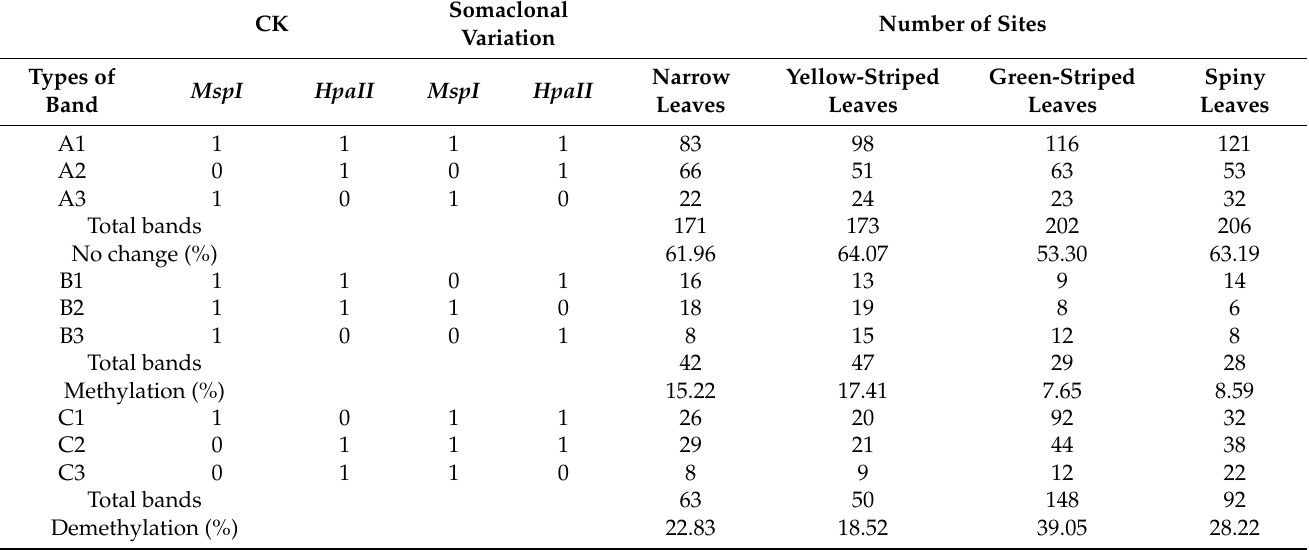
Table 1. The pairwise comparison of methylation and demethylation pattern of variation plants and with